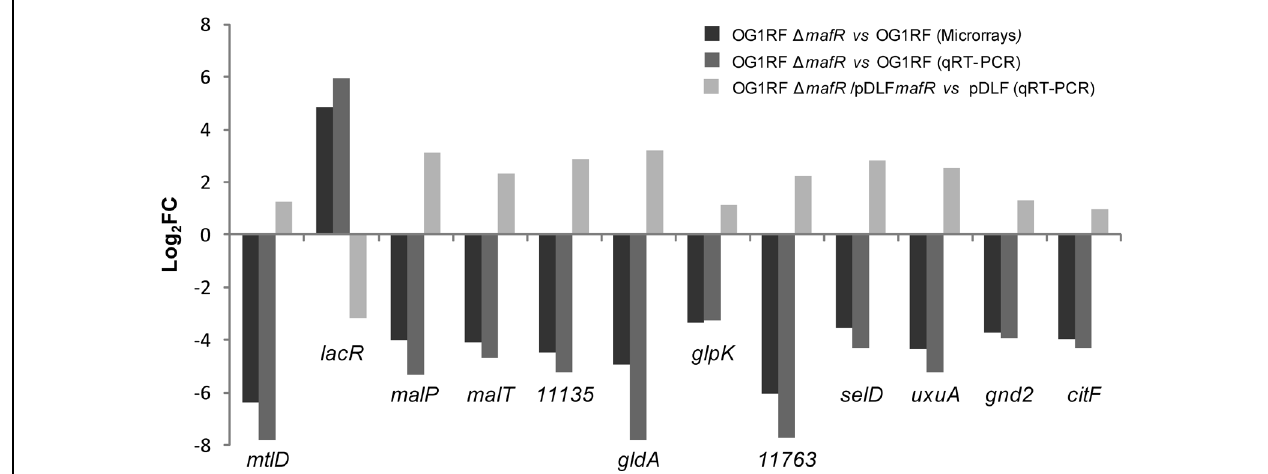
FIGURE 5 | Effect of MafR on gene expression. Log 2 fold change in the expression of the indicated genes due to the lack of MafR (OG1RF (cid:2) mafR vs. OG1RF) determined by microarray analysis and by qRT-PCR. Log 2 fold change in gene expression due to the presence of the MafR-encoding plasmid (OG1RF (cid:2) mafR /pDLF mafR vs. OG1RF (cid:2) mafR /pDLF).